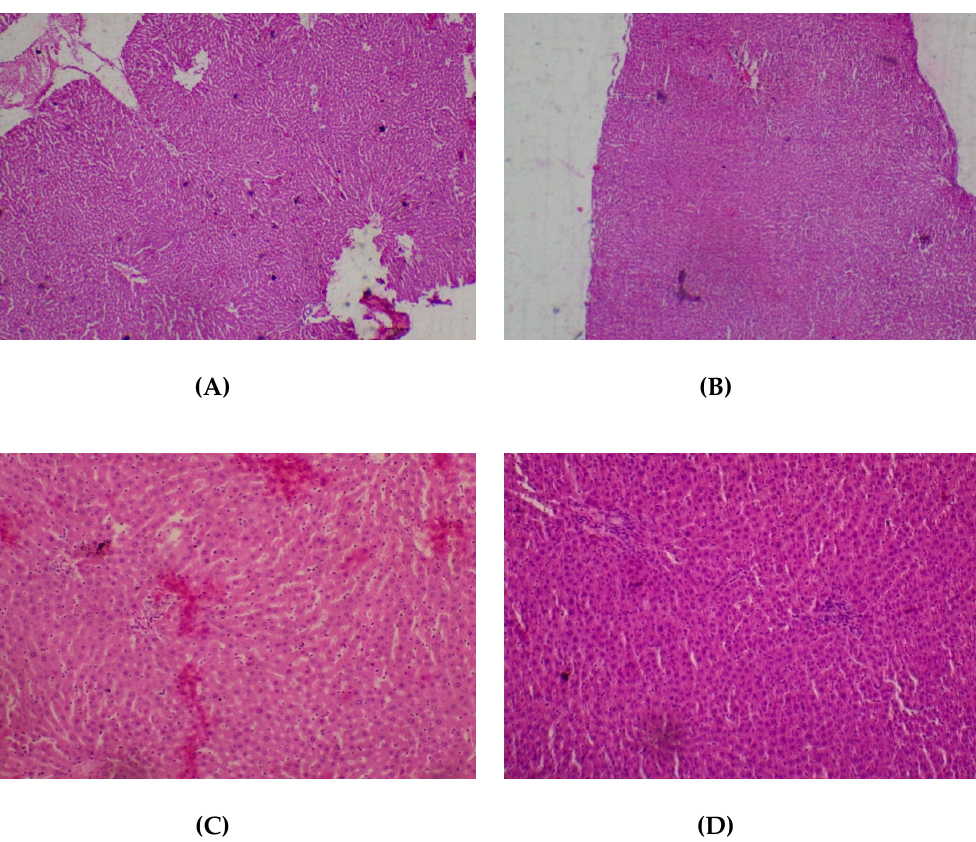
Figure 5. Histopathological presentation of rat liver. ( A ) represents the control group treated with distilled water (Normal); ( B ) represents the group treated with 80 mg/kg T. occidentalis extract (Normal); ( C ) represents the group treated with 400 mg/kg T. occidentalis extract (normal) and ( D ) represents the group treated with 2000 mg/kg T. occidentalis extract (Normal) ( × 400). The liver tissue shows normal radial plates of hepatocytes. No cytoplasmic fat vacuoles or areas of necrosis are seen. The pancreas was normal (80–2000 mg/kg) with observation of closely packed acini, separated by delicate fibrocollagenous stroma that transmits blood vessels (Figure 6).